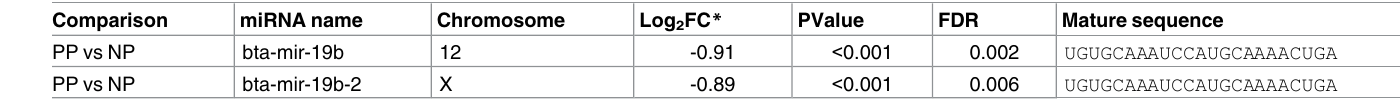
Table 3. miRNAs expression in PP compared with NP animals. Comparison